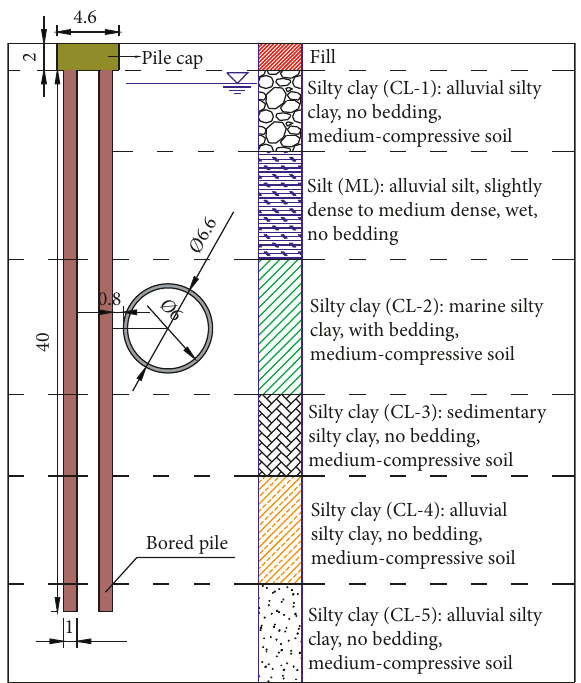
Figure 3: Engineering geological profile (unit: m).